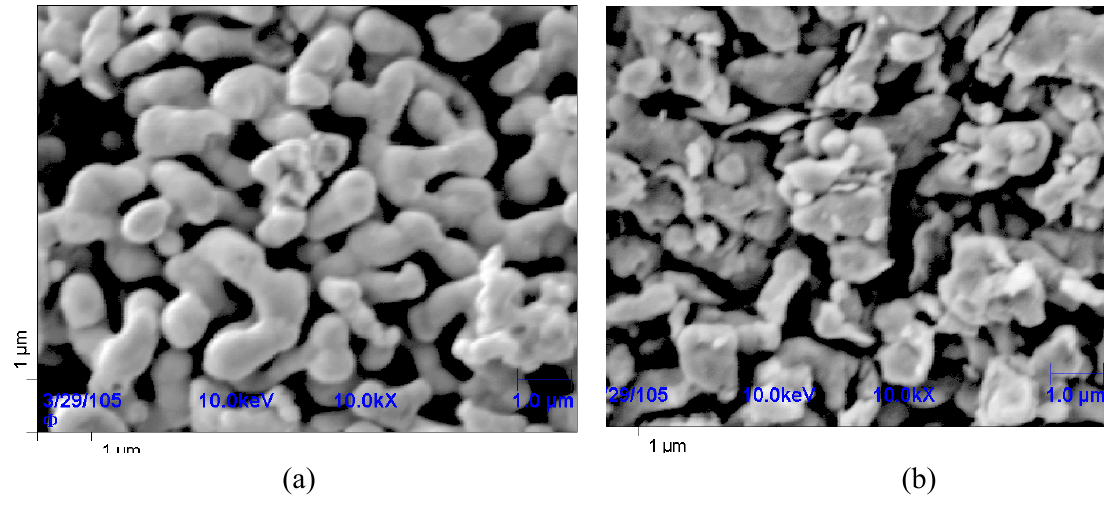
Figure 1. Morphology of (a) initial Co powder and (b) Co + WC mixture after